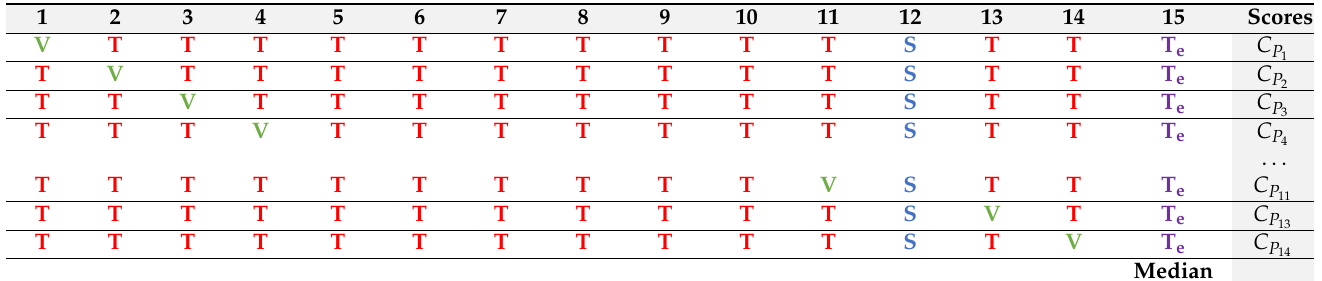
is for the score calculated on the q q